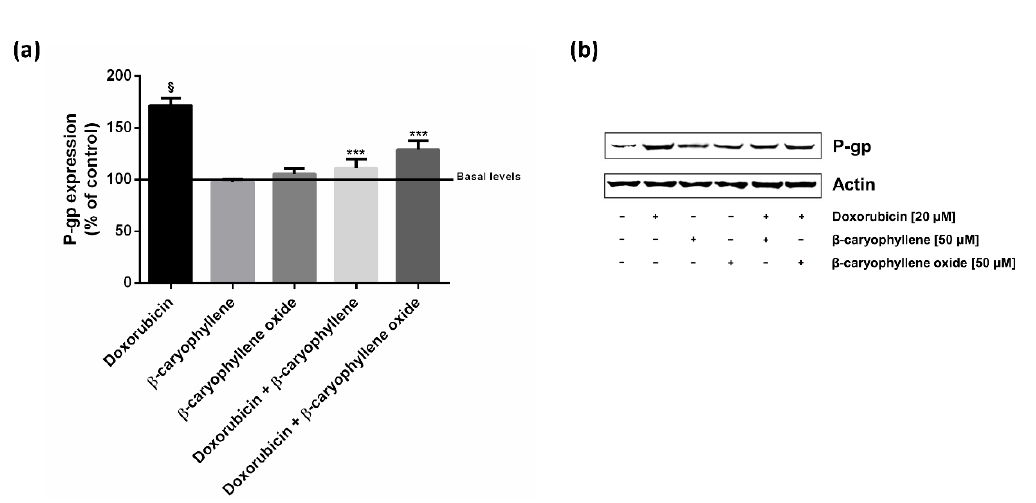
Figure 6. Effect of the sesquiterpenes β -caryophyllene and β -caryophyllene oxide on P-gp expression induced by doxorubicin in HepG2 cells. The cells were exposed to caryophyllane sesquiterpenes (50 µ M), doxorubicin (20 µ M) or their combination for 2 h. Then, the pellets were harvested for the western blotting analysis. The basal level represents the P-gp expression in the vehicle control. ( a ) Densitometric bar graph analysis obtained from at least two independent replicates. Data are expressed as mean ± standard error. ( b ) Representative western blotting image showing the expression levels of P-gp and β -actin used as protein loading control. *** p < 0.001 ( t -Student test), significantly lower than doxorubicin. § p < 0.001 ( t -Student test), significantly higher than the vehicle control (basal level).